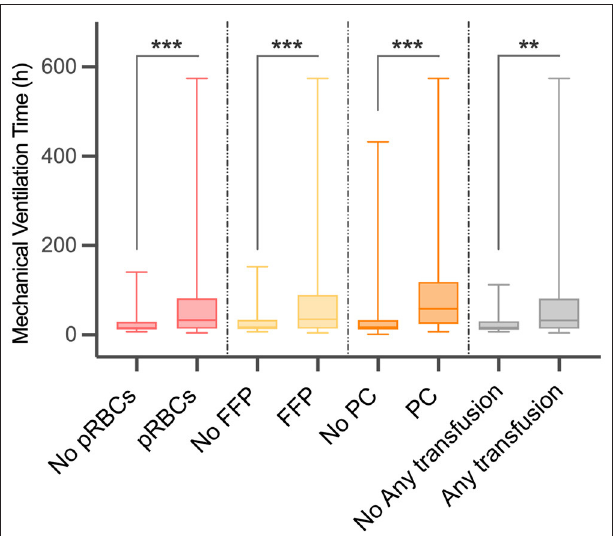
FIGURE 1 | Difference in mechanical ventilation time (MVT) between different blood product transfusion and no transfusion. MVT, mechanical ventilation time; pRBCs, packed red blood cells; FFP, fresh frozen plasma; PC, platelet concentrate. ** p < 0.01, *** p <